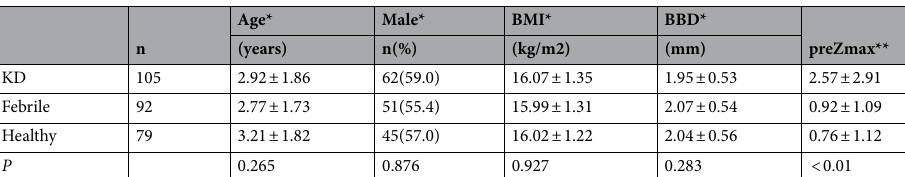
Table 1. Clinical characteristics and ultrasonography features of KD, Febrile and Healthy groups. The data are presented as the mean ± SD for continuous variables and as the percentage for the categorical variables. BMI